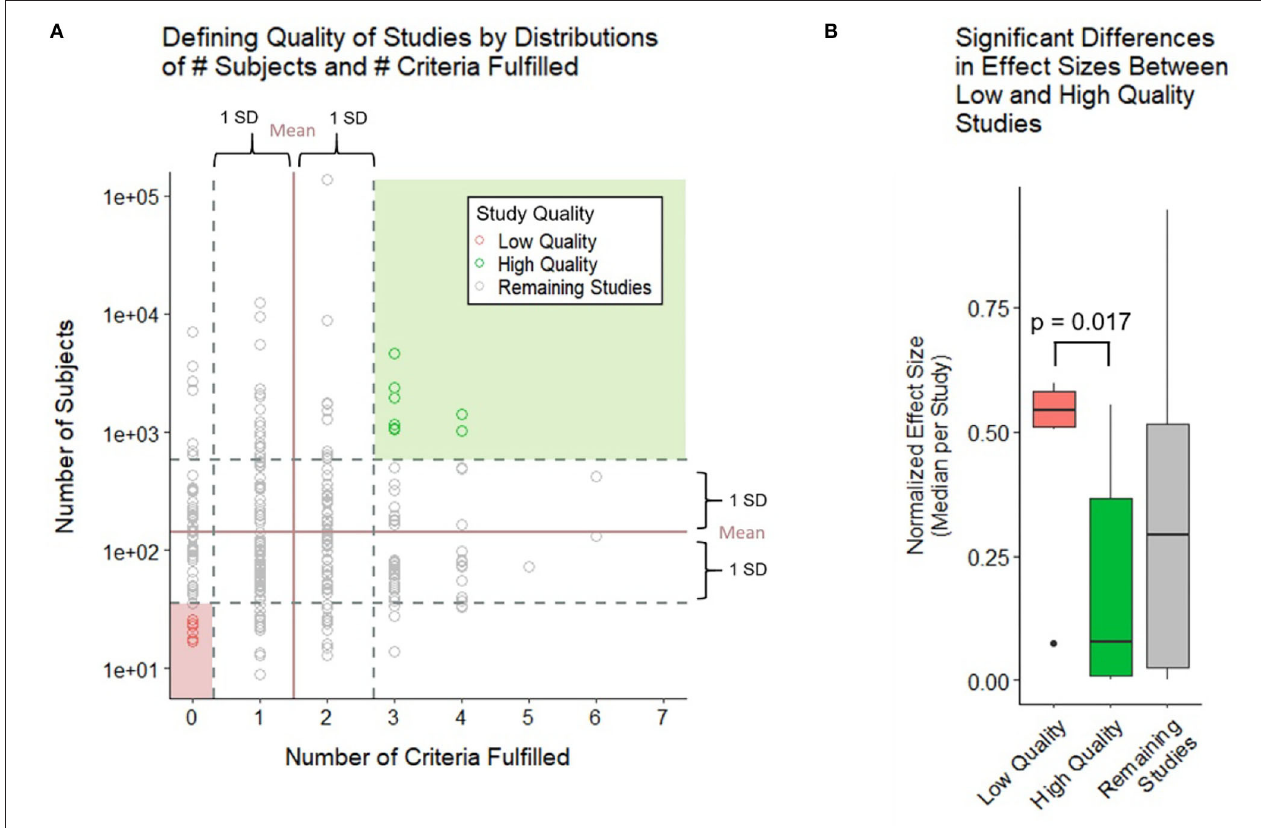
FIGURE 5 | Relationship between technical quality and sample size of the study and reported effect sizes. (A) Study quality is defined by the number of subjects and number of criteria fulfilled with high quality studies falling 1 SD above both criteria and low-quality studies falling 1 SD below both criteria. (B) Boxplot compares the normalized effect sizes between low- and high-quality studies using a two-sample Wilcoxon (Mann–Whitney) test. Low-quality studies were found to have higher effect sizes at a significant p -value of